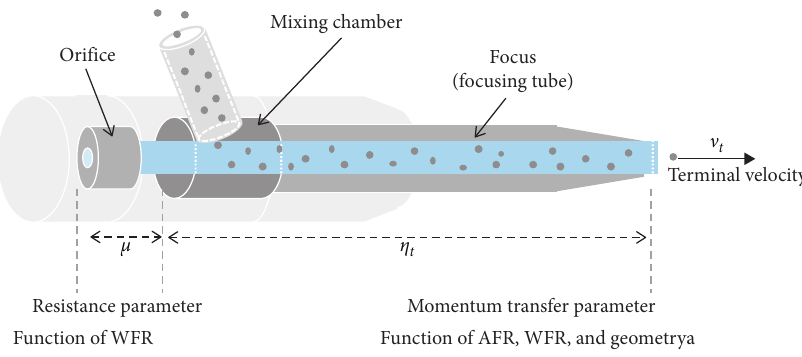
Figure 1: Conceptual image of mixing in the